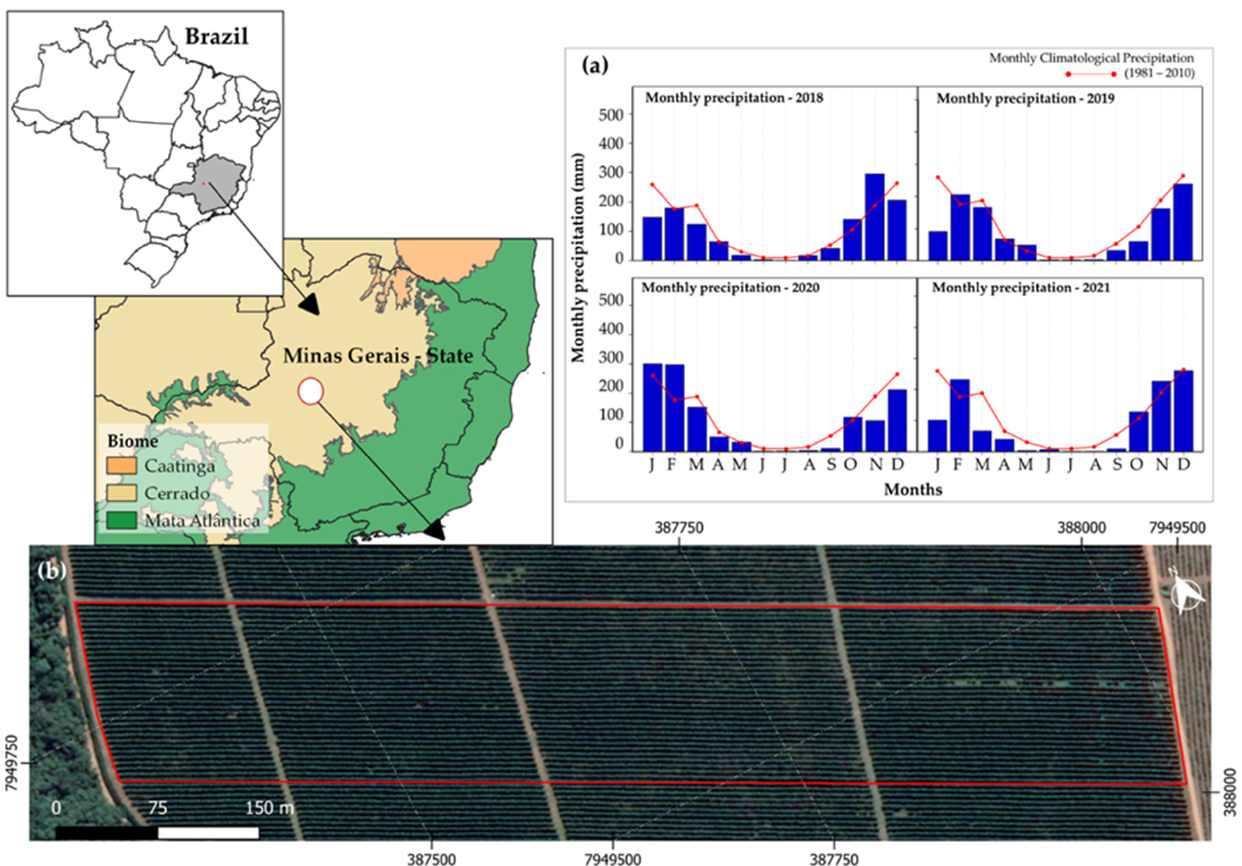
Figure 1. Location of coffee-field study site in Brazil. ( a ) Historical data of monthly precipitation for the years 2018, 2019, 2020 and 2021 and the line with the monthly climatological precipitation of 30 years (1981–2010) for the study area, [39]. ( b ) Study area; the red line represents the area boundary.